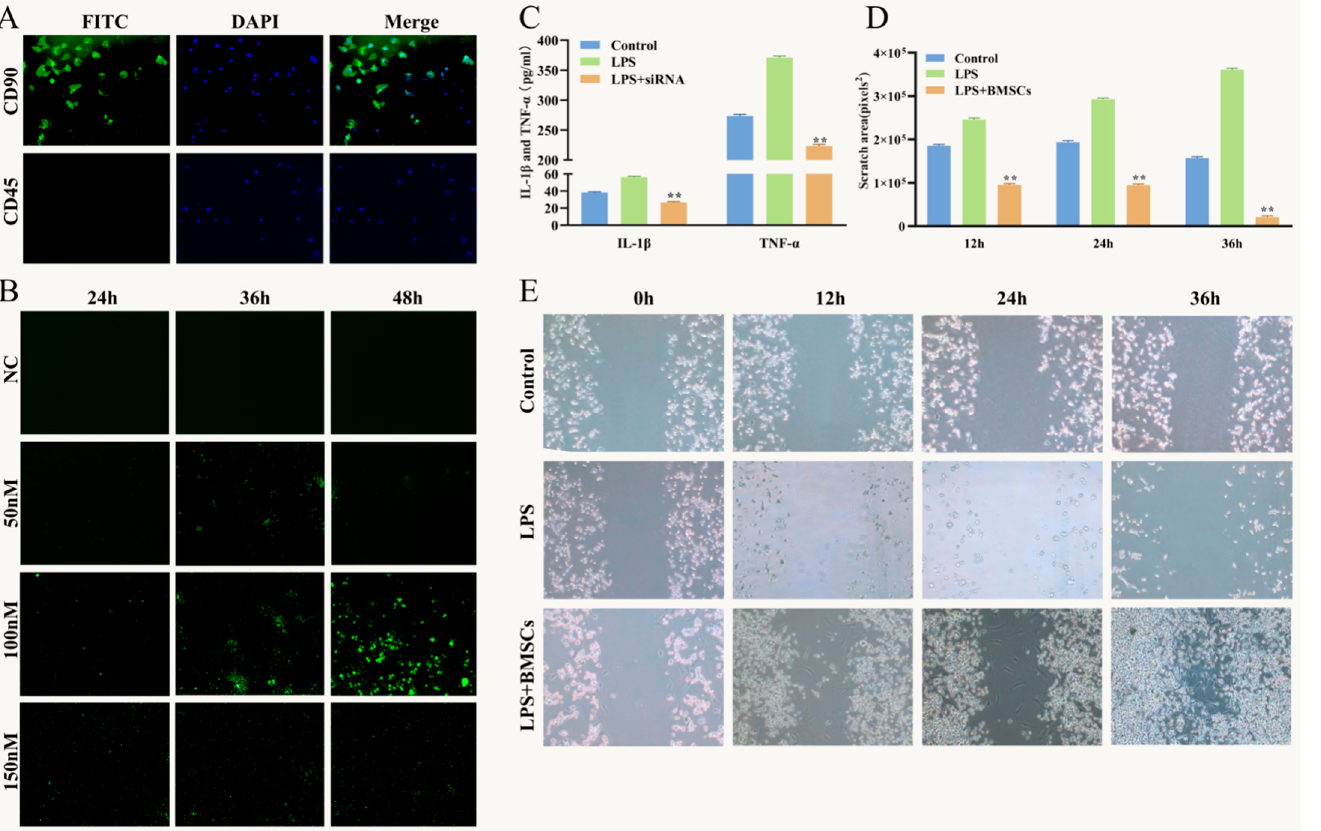
Figure 1. Effects of IL-1 β /TNF- α and BMSCs on inflammatory factors expression and cell migration of RAW264.7. ( A ), BMSCs identification cell immunofluorescence (100 μ m). ( B ), IL-1 β /TNF- α siRNAs were transfected into RAW264.7 at concentrations of 50, 100 and 150 nM and observed under fluorescence microscope (200 μ m). ( C ), The expression of IL-1 β and TNF- α in cell supernatant of RAW264.7 by Elisa. ( D ), The scratch area of RAW264.7 cells was calculated by image ( E ), RAW264.7 cells were observed under inverted microscope at 0 h, 12 h, 24 h and 36 h after scratch experiment (100 µ m). Data are presented as the mean ± SD ( n = 6/group), ** p < 0.01 vs. LPS